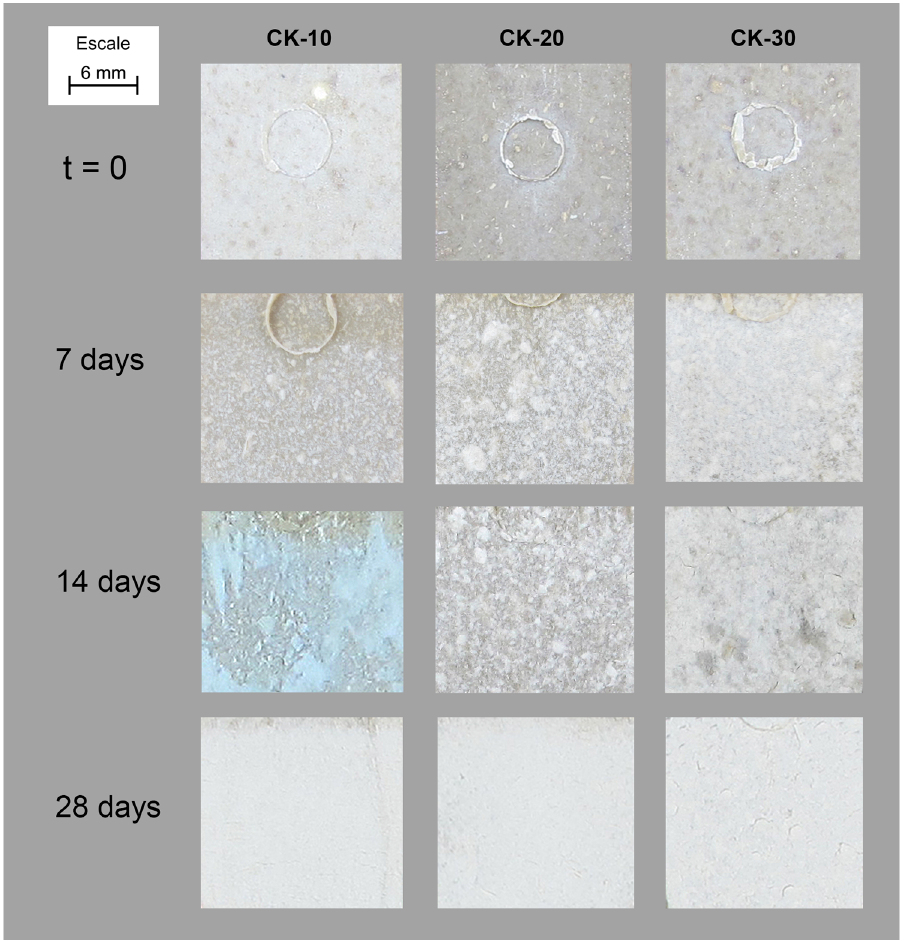
Figure 3. Evolution of the surface of CK ‐ composites inside Xenotest chamber.